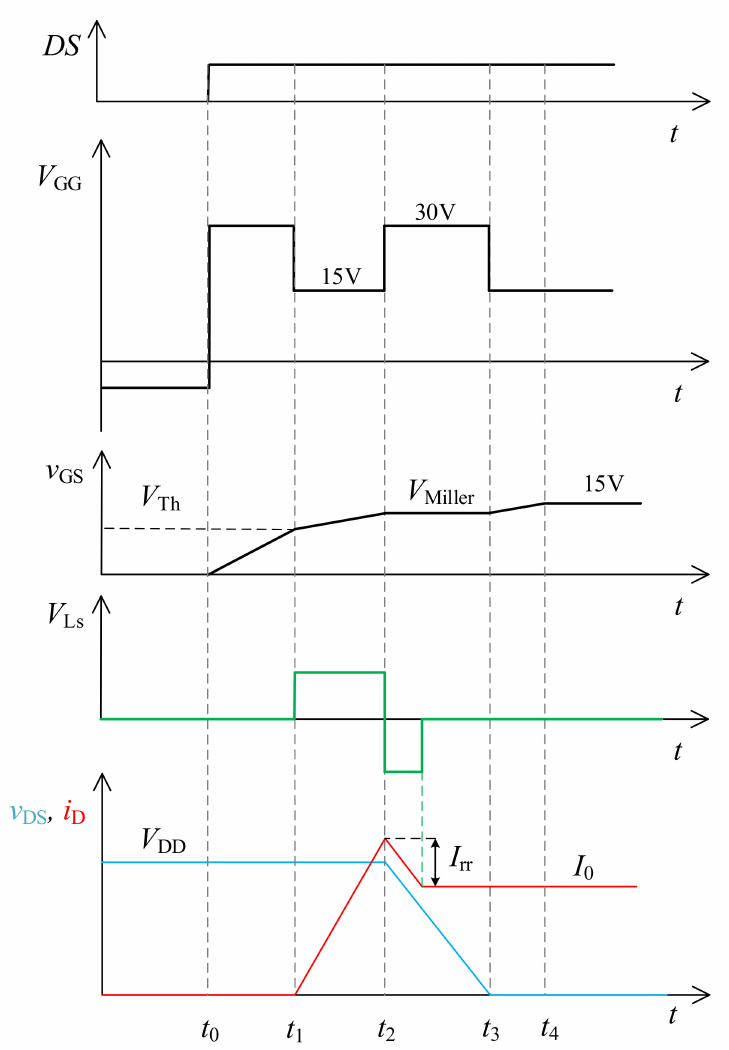
Figure 2. The multi-level gate voltage method waveforms for the turn-on cycle improvement of the SiC MOSFET with an inductive load. DS —logical driving signal of the device, V GG —gate voltage of the SiC MOSFET, v GS —gate-source voltage, v DS —drain-source voltage, i D —drain current, V DD —drain-source voltage before the turn-on of the MOSFET, I 0 —drain current after switching on the device, V Th —threshold voltage, V Miller —Miller voltage, I rr —drain current overshoot, V Ls —ideal source parasitic inductance voltage